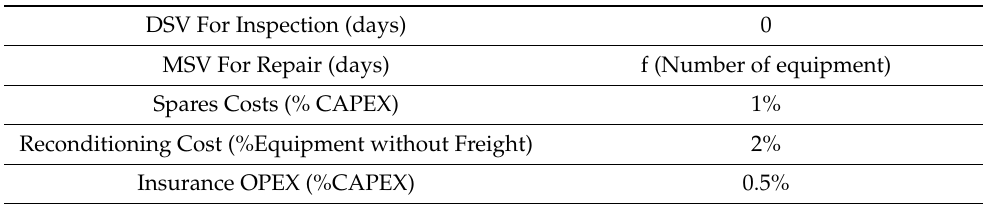
Table 4. Items considerer for the